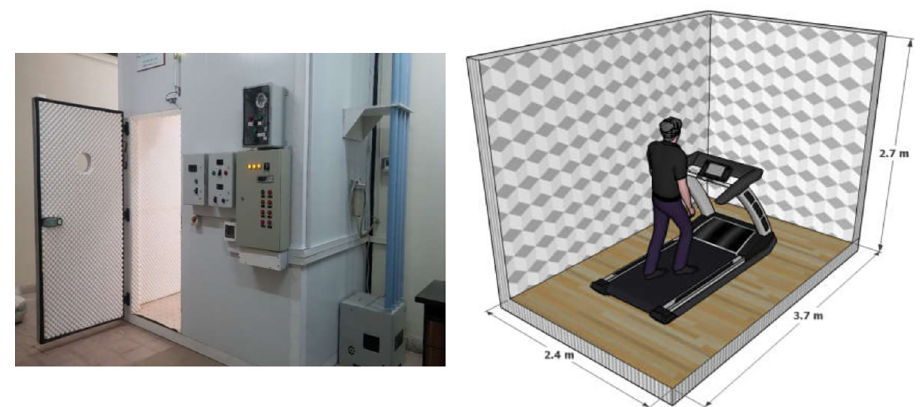
Fig 2. Climate-controlled room for